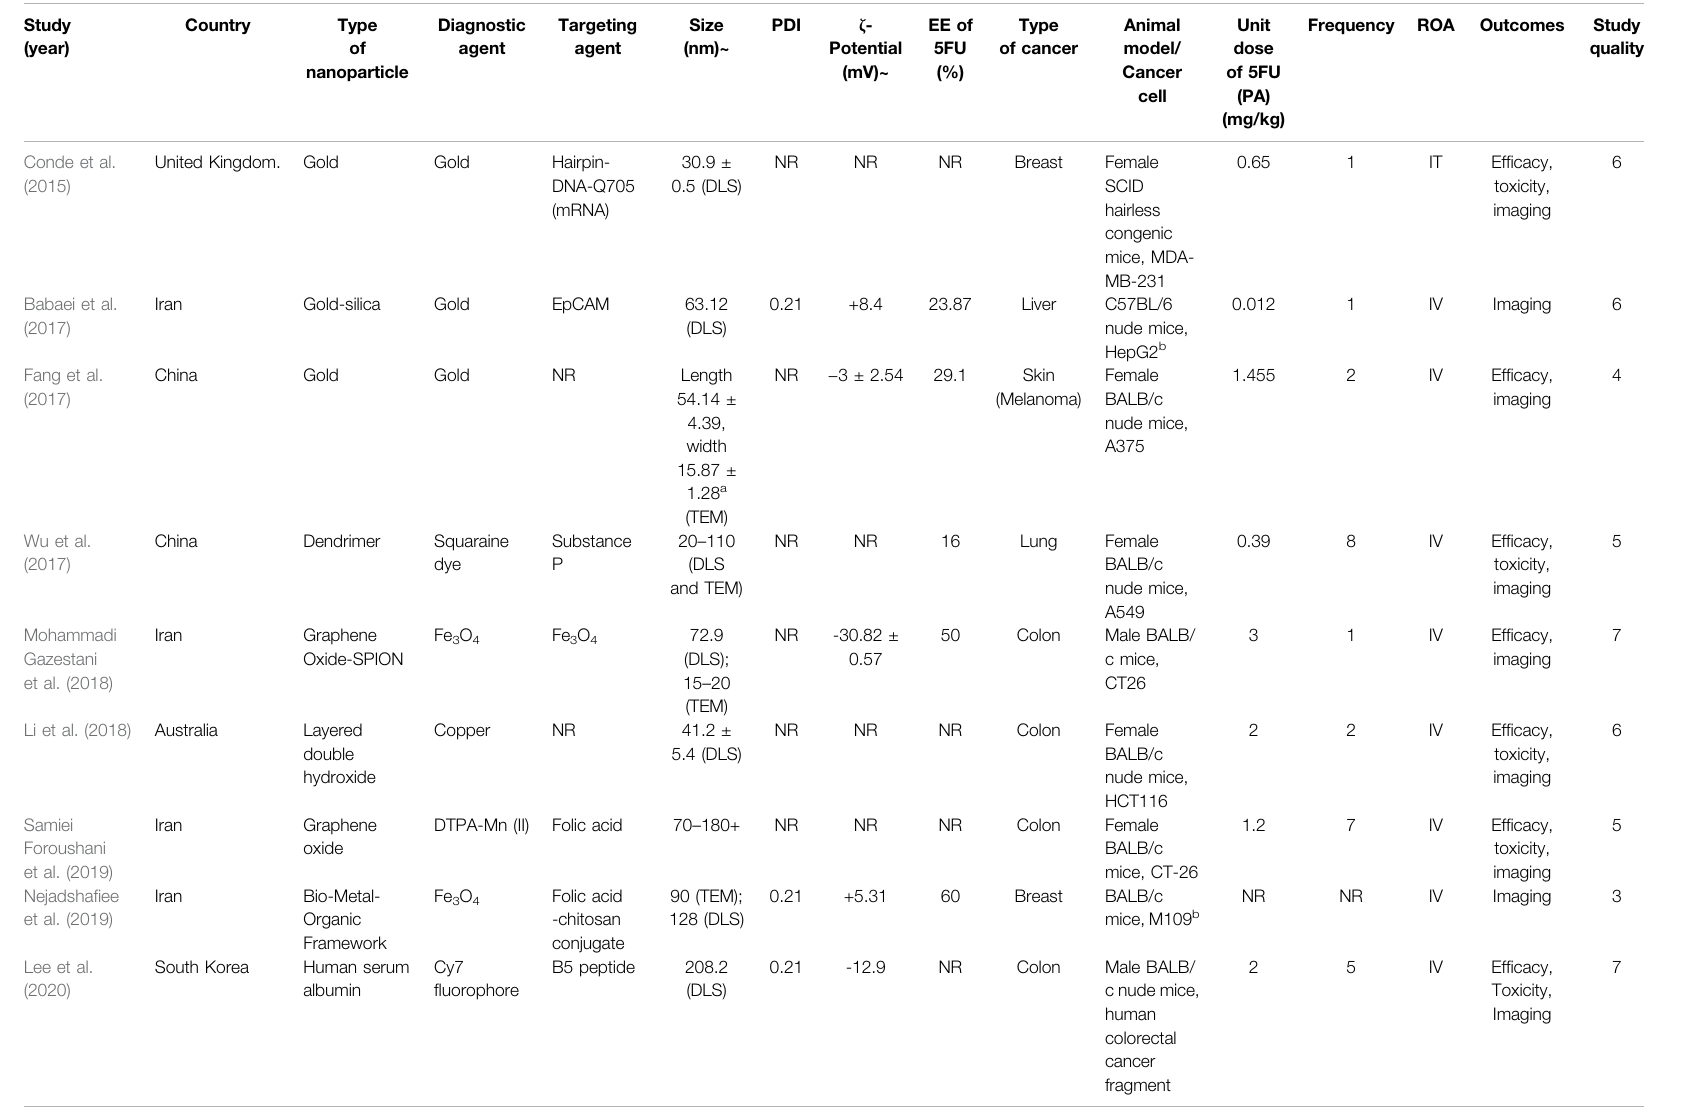
TABLE 1 | General characteristics of the included